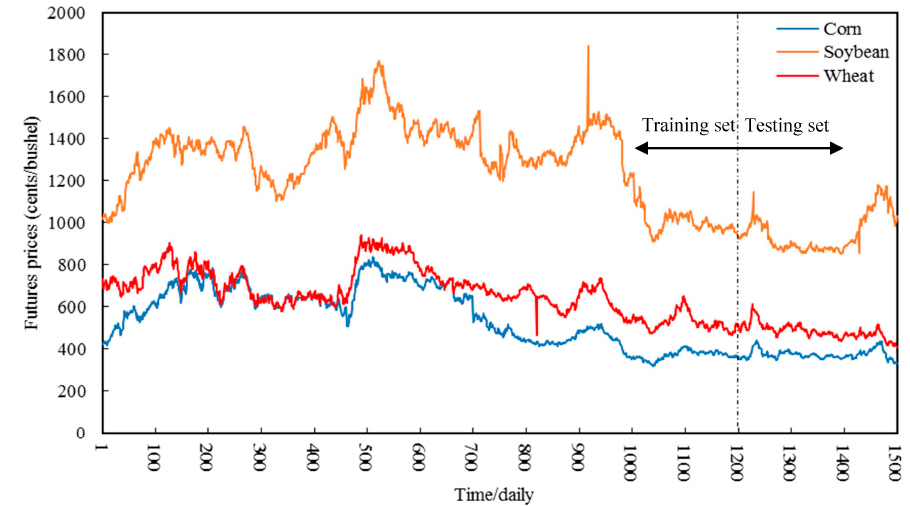
Figure 4. Futures prices series of corn, soybean and wheat.